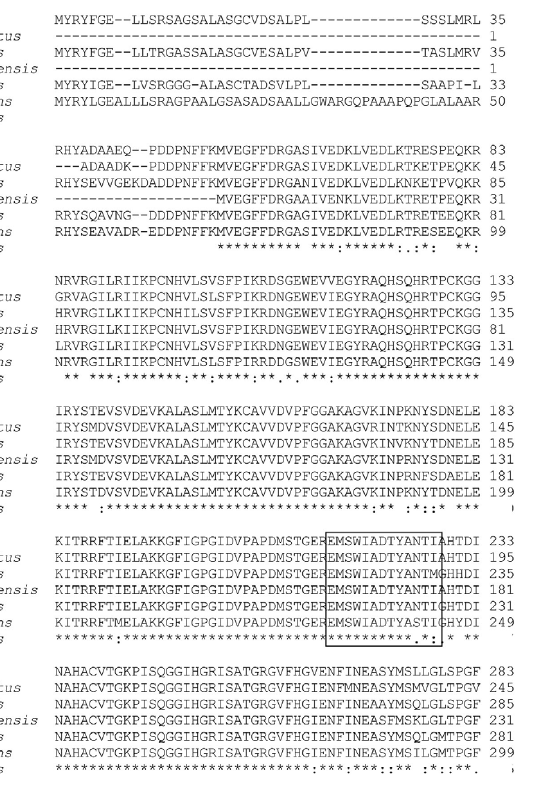
FIGURE 2 |The alignment of the translated amino acid sequence of glutamate dehydrogenase 1a (Gdh1a) from the liver of Monopterus albus and the amino acid sequences of Gdh in Chaenocephalus aceratus (P82264.1), Oncorhynchus mykiss (NP_001166000.1), Tribolodon hakonensis (BAD83654.1), Xenopus laevis (NP_001087023.1), and Homo